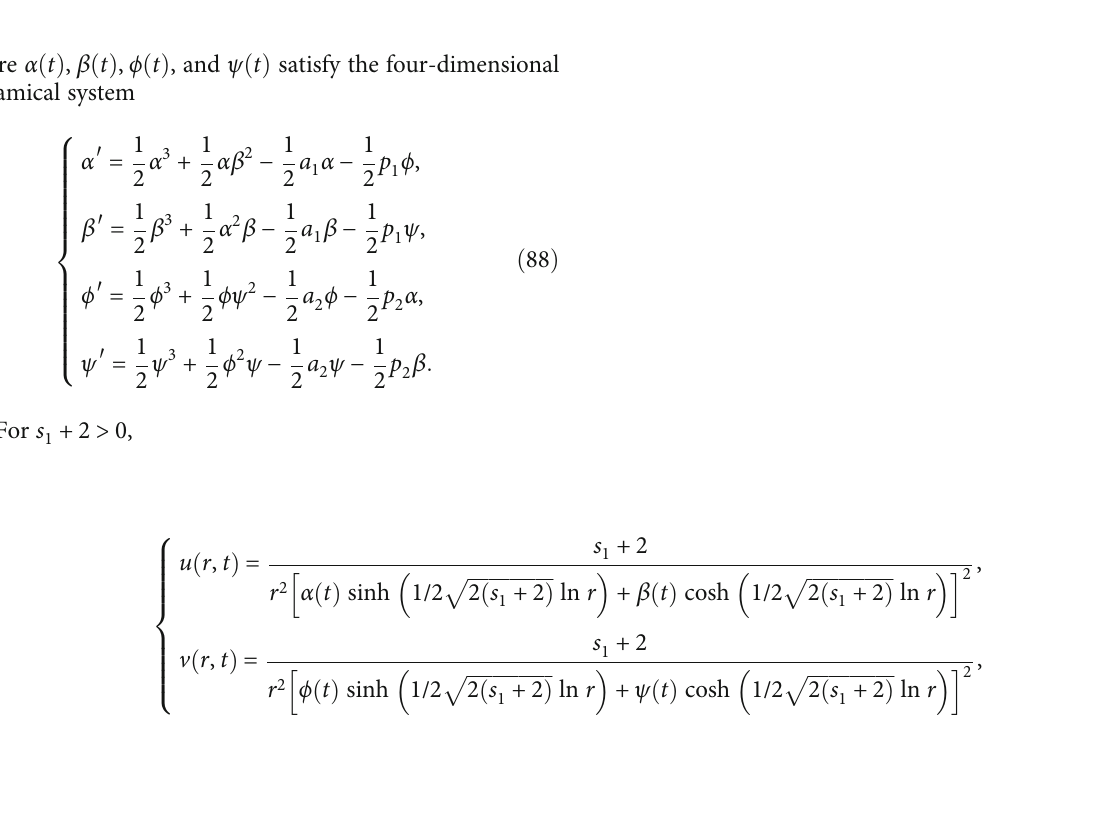
ffiffiffiffiffiffiffiffiffiffiffiffiffiffiffiffiffiffiffiffi − 2 s